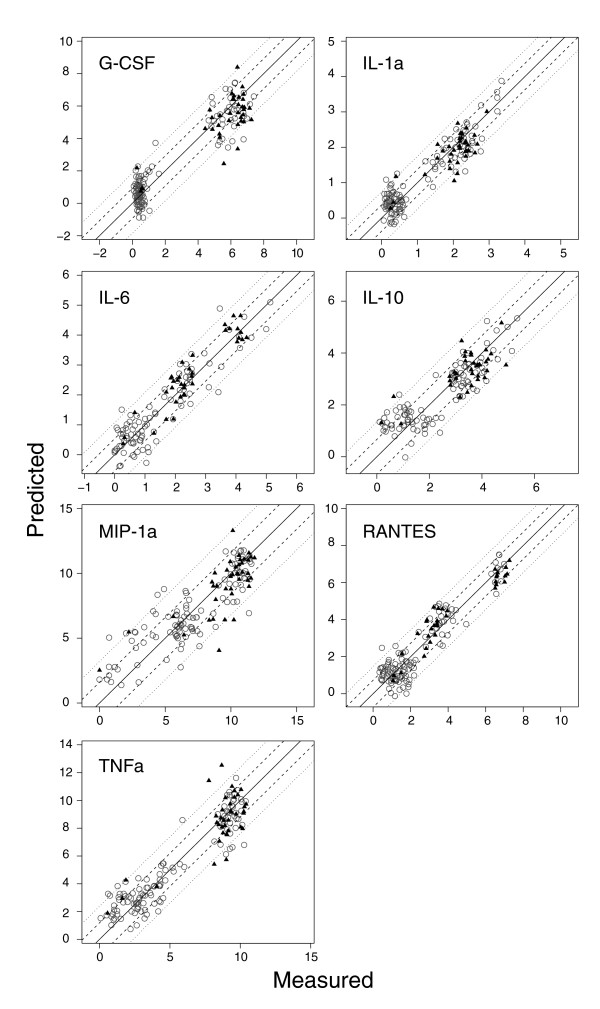
Prediction of training and test data on cytokine release using PCR minimal models. Measured versus predicted log-transformed concentration values are indicated for training data (unfilled circles) and test data (filled triangles). Dashed and dotted lines indicate one and two standard deviations, respectively, from the average predicted fit of the training data.